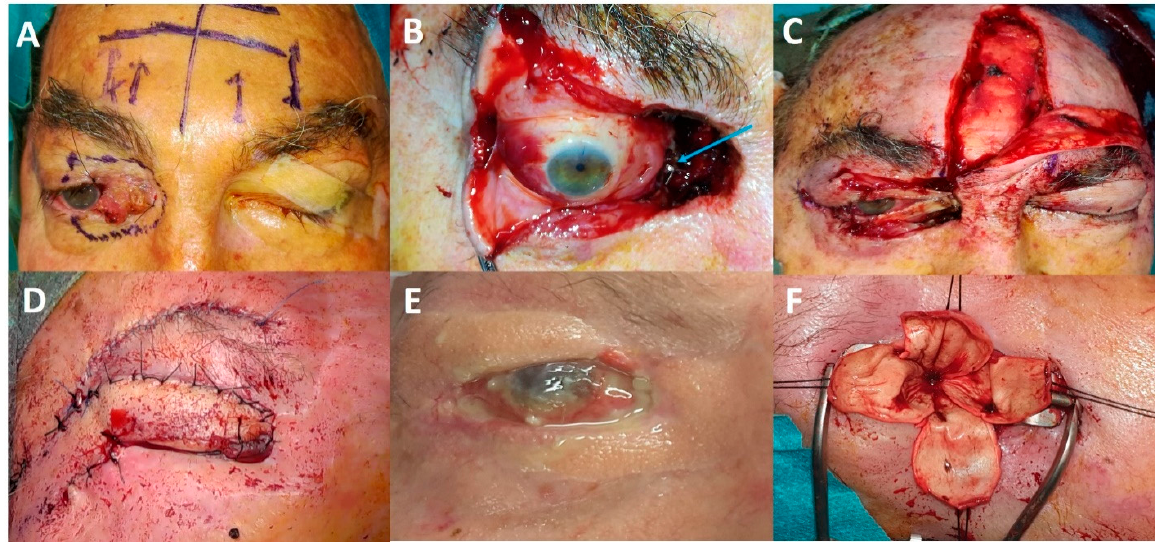
Figure 5. Illustrative case of eye-sparing surgery: ( A ) A 68-year-old patient with upper and lower eyelid squamous cell carcinoma with anterior and extraconal orbital involvement. ( B ) Removal of half of the upper and lower eyelids, lacrimal sac and tantalum clip placement for adjuvant proton beam therapy (blue arrow). ( C ) Reconstruction performed using a tarsal graft, a conchal graft and a frontalis muscle flap. ( D ) Second surgery: frontotemporal flap (Fricke flap) used to correct the upper eyelid retraction and subsequent corneal exposure. ( E ) Flap retraction associated with chronic painful corneal ulcer. ( F ) Third surgery: eye evisceration to relieve unbearable eye pain.